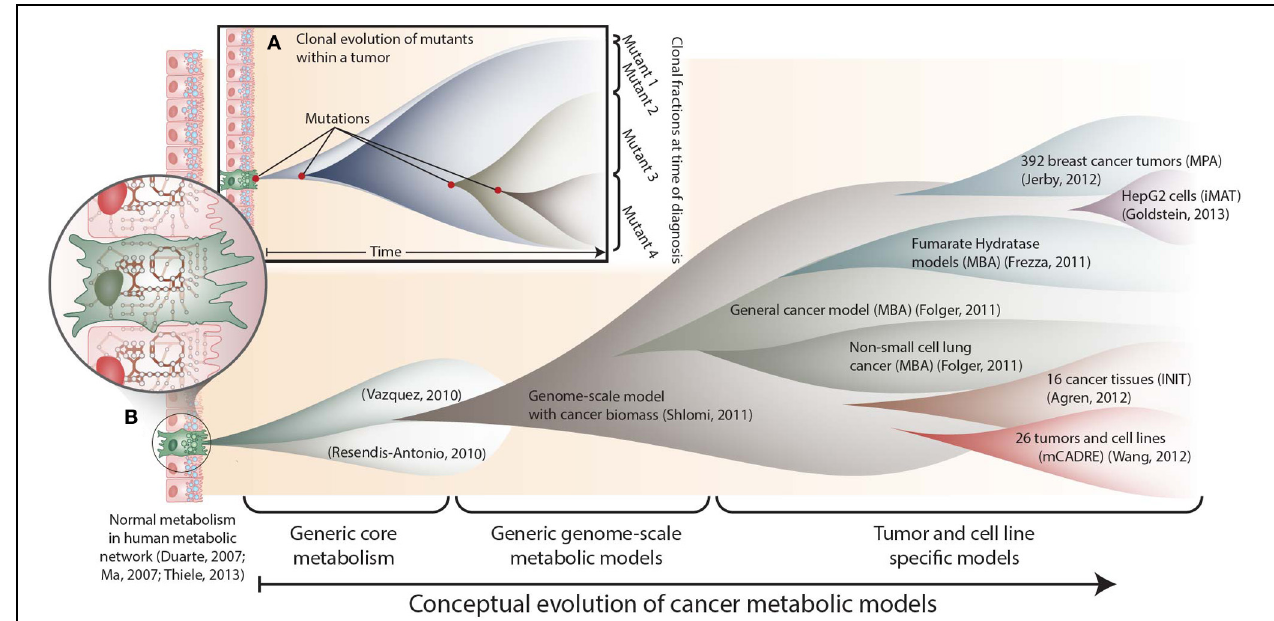
FIGURE 1 | The conceptual evolution of constraint-based models of cancer metabolism. (A) Clonal evolution commonly occurs in a developing tumor as new mutations are acquired that confer increased growth capabilities to new mutants. At the time of diagnosis, a tumor often consists of a mixed population of cancerous cells. (B) Similarly, the scope and specificity of cancer metabolic models have rapidly evolved over the past few years. Genome-scale metabolic network reconstructions have provided a valuable resource, since they contain thousands of known human metabolic reactions (Duarte et al., 2007; Ma et al., 2007; Thiele et al., 2013). This knowledge enabled the first two cancer-specific metabolic models, which focused on core metabolic pathways(Resendis-Antonio et al., 2010; Vazquez